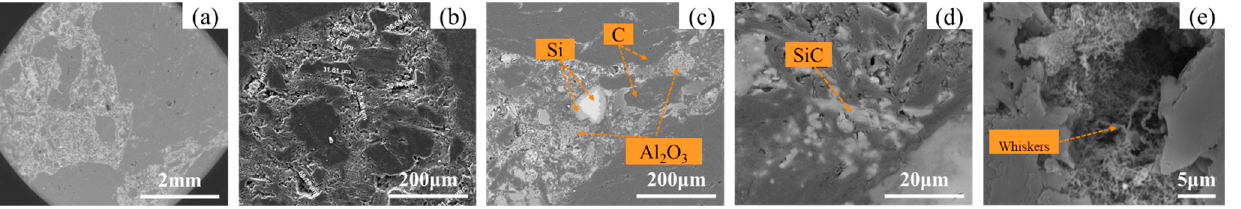
Figure 7. ( a – e ) Microscopic morphology of the original brick A under different scaleplates.